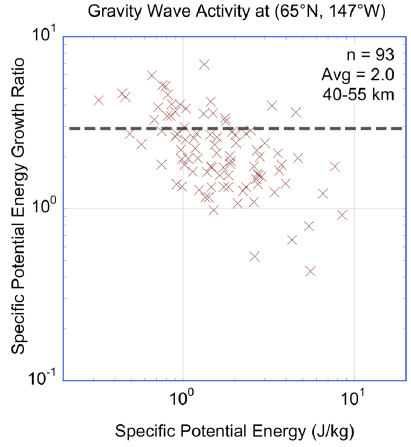
Figure 4. Growth ratio of gravity wave specific potential energy ((47.5–55 km)/(40–47.5 km) as a function of specific potential energy (40.0–47.5 km). The dashed line is plotted at a value of 2.9 and represents the ratio for freely propagating gravity waves that are conserving their energy.